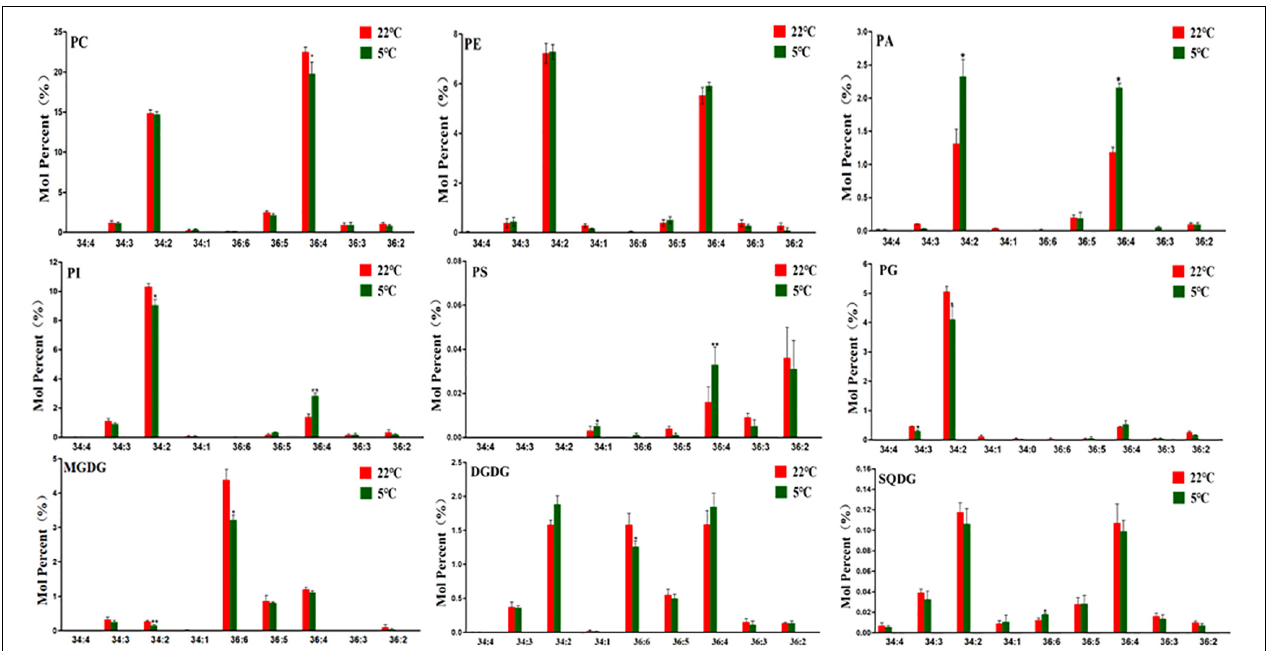
FIGURE 2 | Changes in molecular species of major membrane lipids in maize roots under cold stress (5 ◦ C). PC, phosphatidylcholine; PE, phosphatidylethanolamine; PA, phosphatidic acid; PI, phosphatidylinositol; PS, phosphatidylserine; PG, phosphatidylglycerol; MGDG, monogalactosyldiacylglycerol; DGDG,